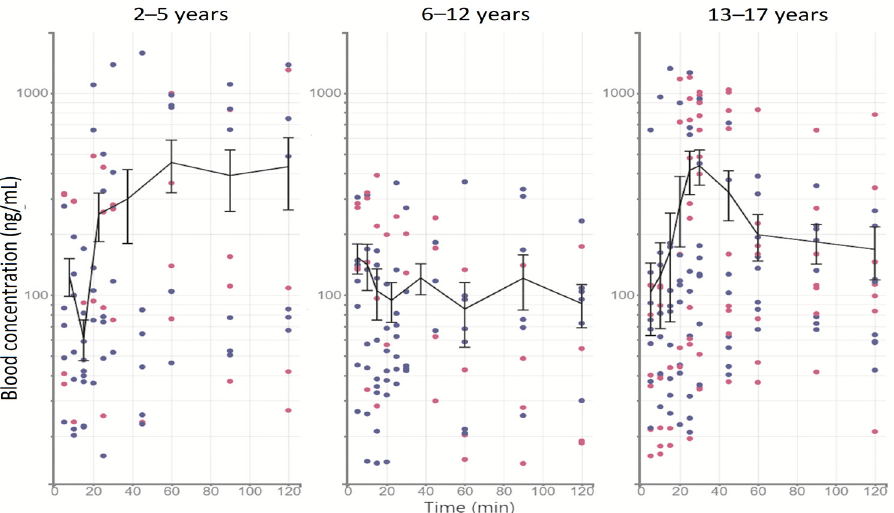
Figure 1. Pharmacokinetic profiles distributed by age range. The line describes the arithmetic mean ± SE. Blue points indicate male patients and pink points indicate female patients.